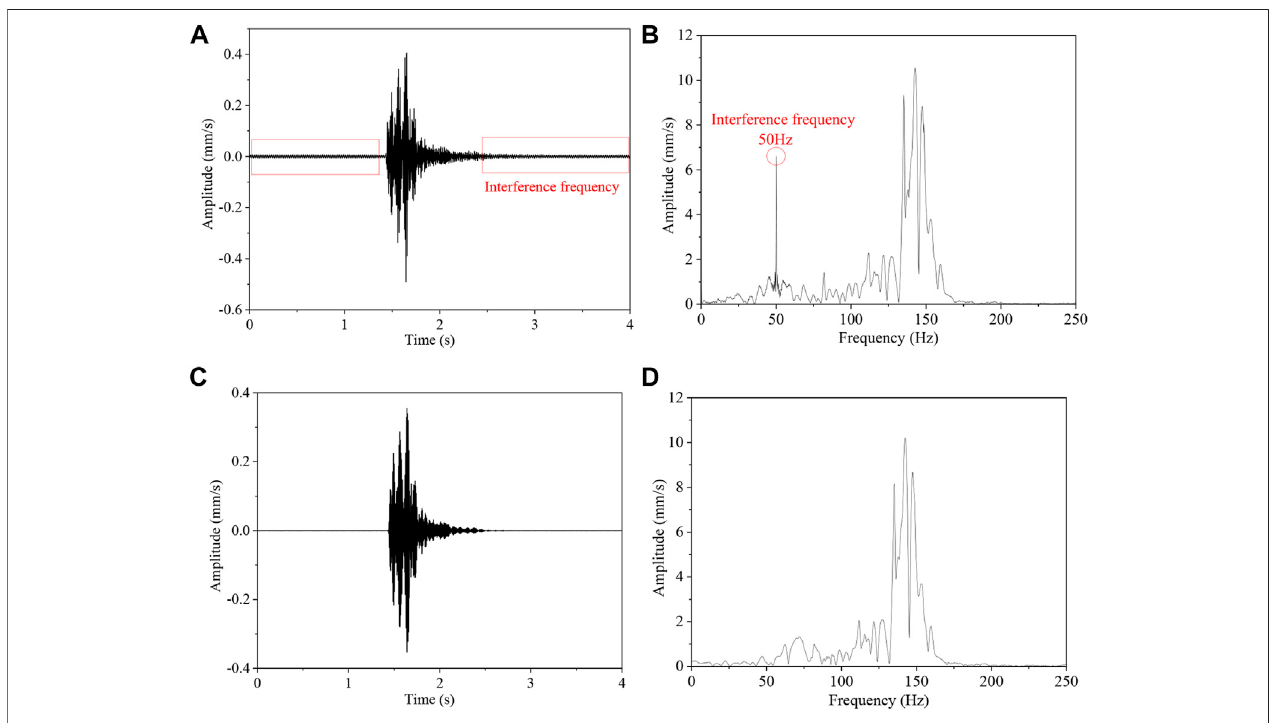
FIGURE 3 | Waveform and frequency spectrum of original and de-noising waveform. (A) Original waveform; (B) frequency spectrum of the original waveform; (C) de-noising waveform; and (D) frequency spectrum of the de-noising waveform.